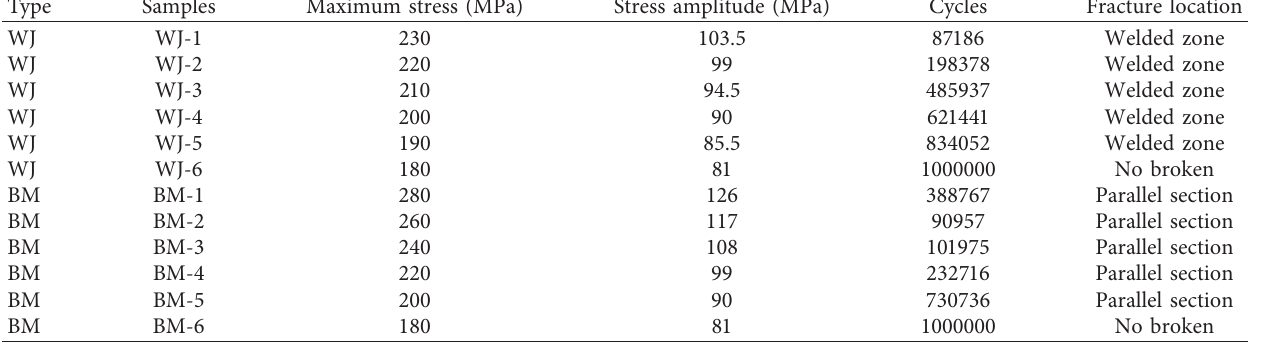
Table.3: Date of fatigue tests of 6061 BM and welded joints.